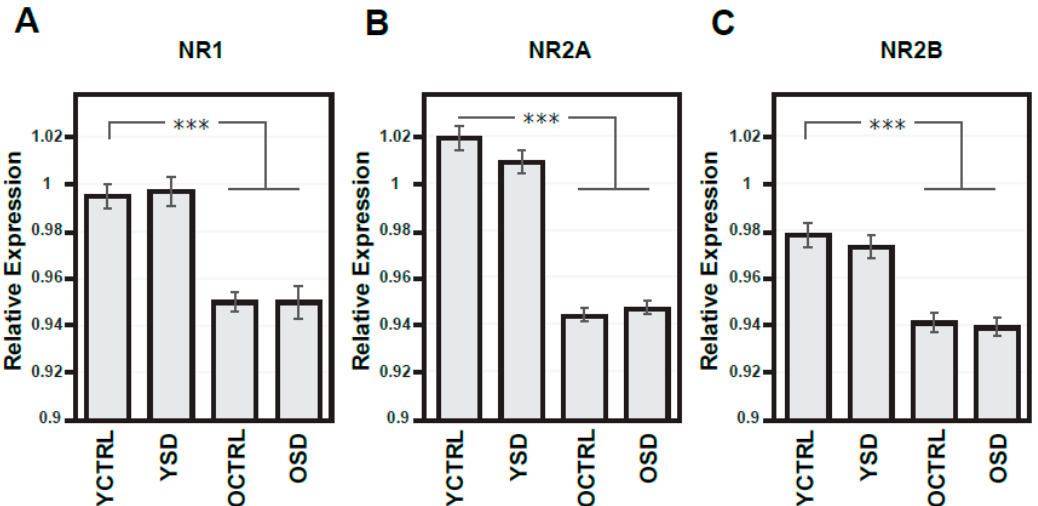
Figure 4. Expressions of NMDA receptor subunits in the frontal cortex from both hemispheres in young adult and old rats exposed to acute sleep deprivation. Optical density of samples respective NMDA subunit bands ( A – C ) related to that of α -tubulin; results are presented as means ± SEM. Statistical significance (Student’s t -test) was calculated with respect to young adult controls (*** p < 0.001). SD—sleep deprivation, YCTRL—young adult controls ( n = 12), YSD—young adult rats exposed to acute SD ( n = 12), OCTRL—old controls ( n = 12), OSD—old rats exposed to acute SD ( n = 12).